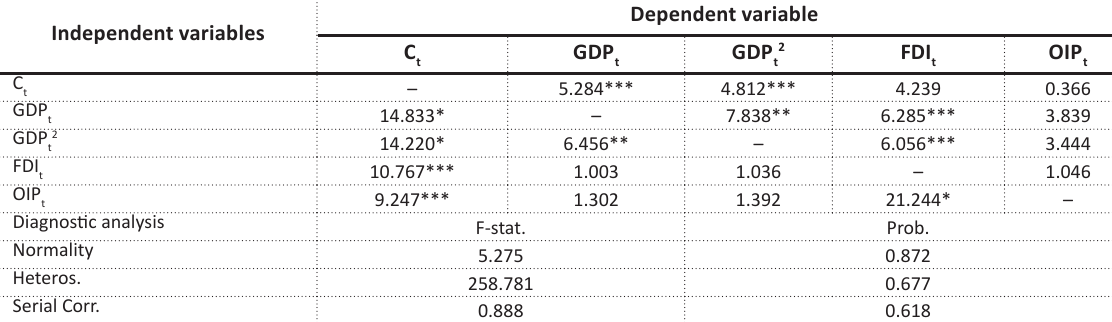
Table 9. Causality analysis